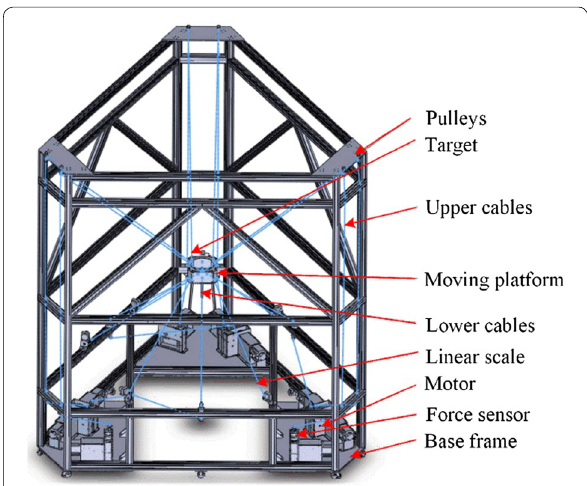
Figure 1 Schematic diagram of proposed nine-cable-driven parallel mechanism